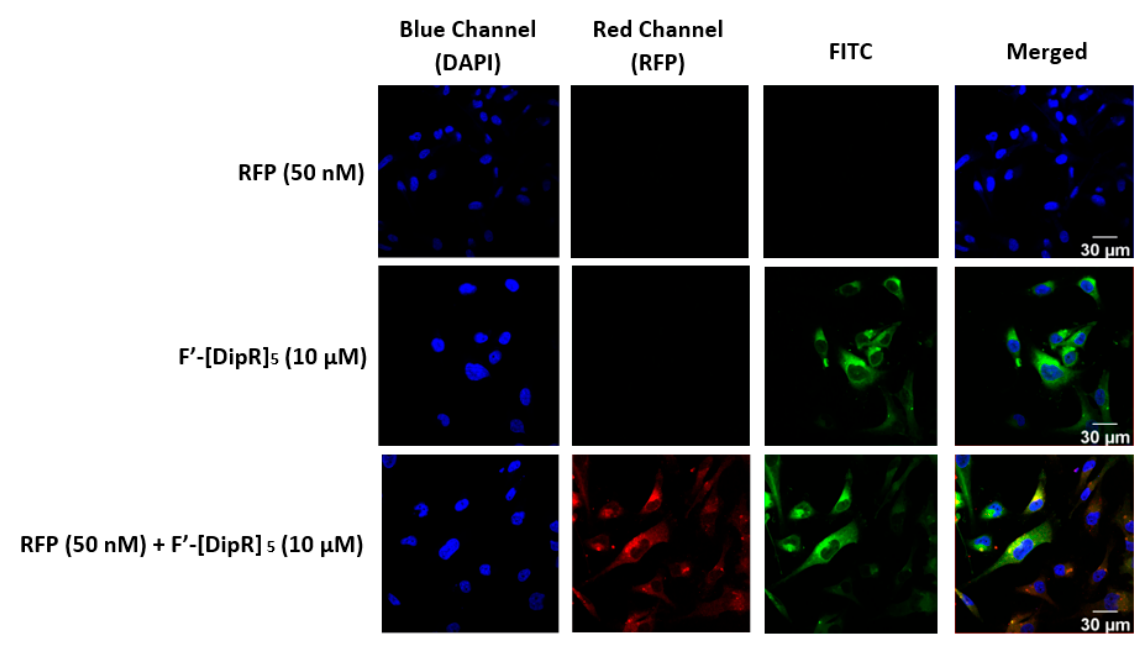
Figure 14. Confocal microscopy images of MDA-MB-231 cells incubated with the F ′ -[DipR] 5 or RFP- F ′ -[DipR] 5 mixture at a peptide concentration (10 µM) and RFP at (50 nM) for 3 h. The red and blue channels visualize RFP and DAPI (used to stain the nucleus), respectively.